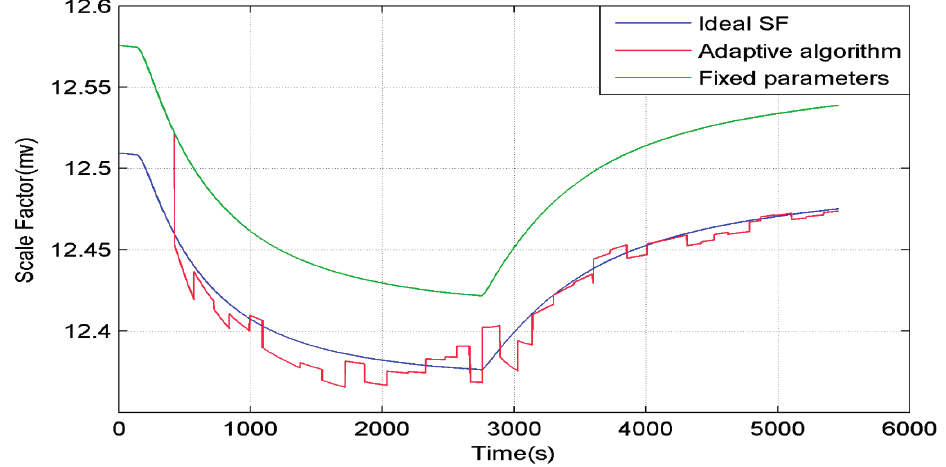
Figure 10. The SF in simulation.